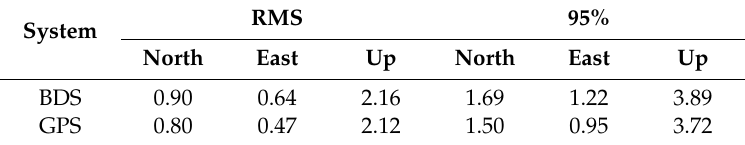
Table 3. SPP performance of current BDS and GPS system (in meter).